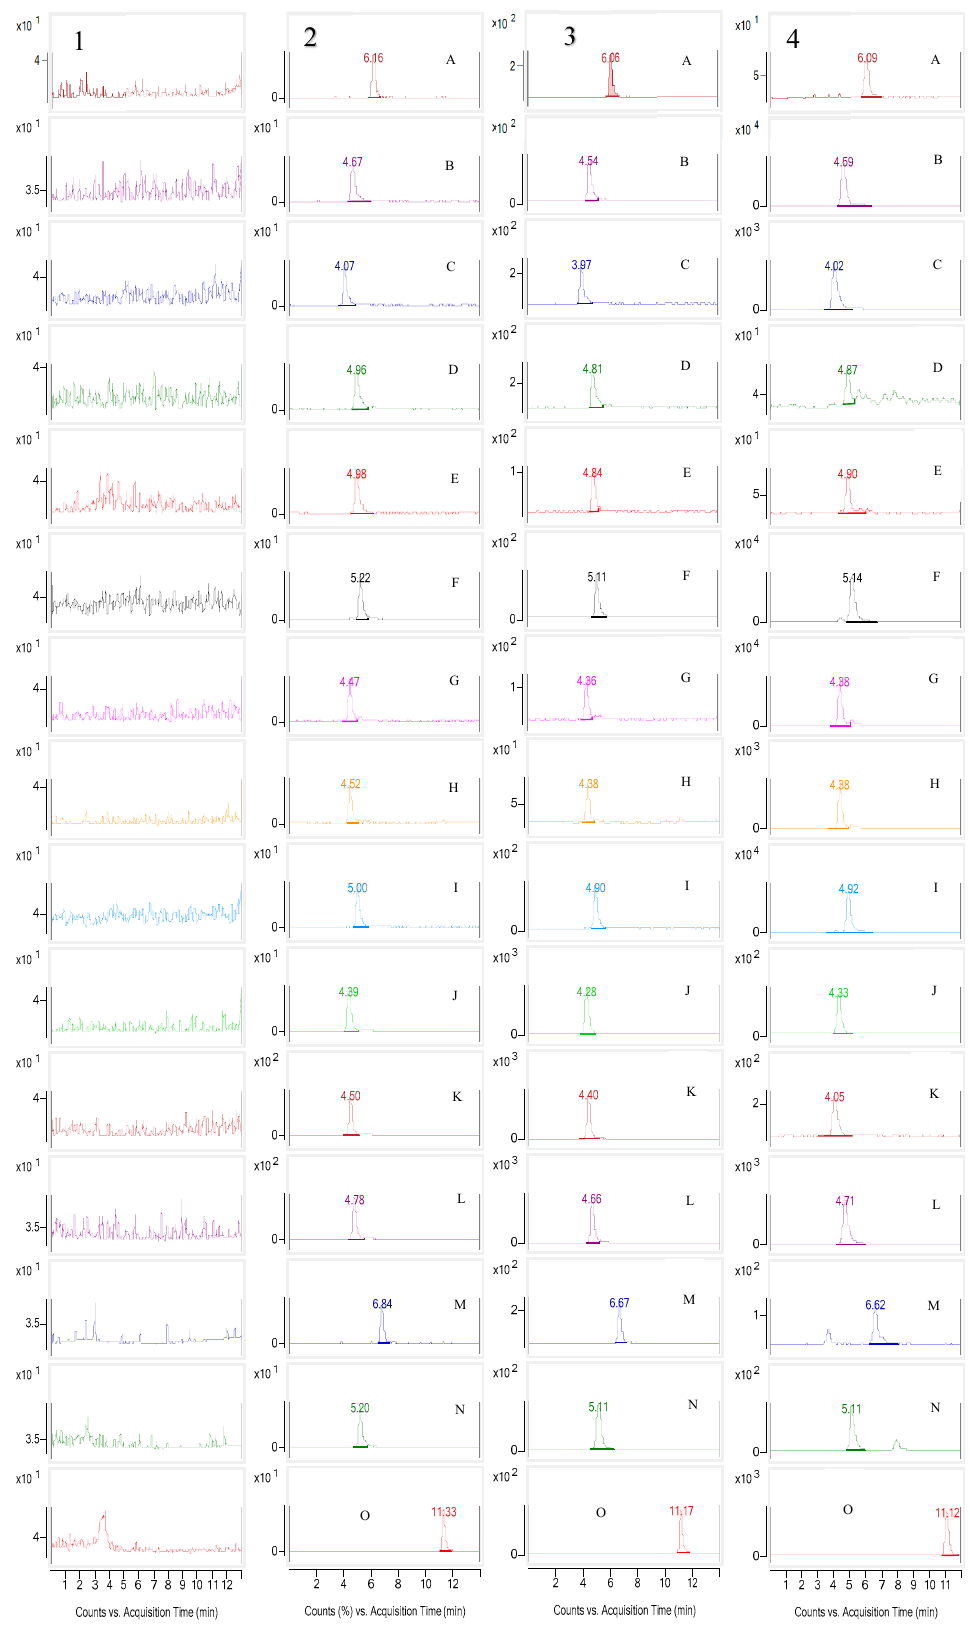
Figure 1. (1) Blank sample (without the fourteen analytes and I.S.) (2) Blank plasma spiked with the fourteen analytes and I.S. (LLOQ: